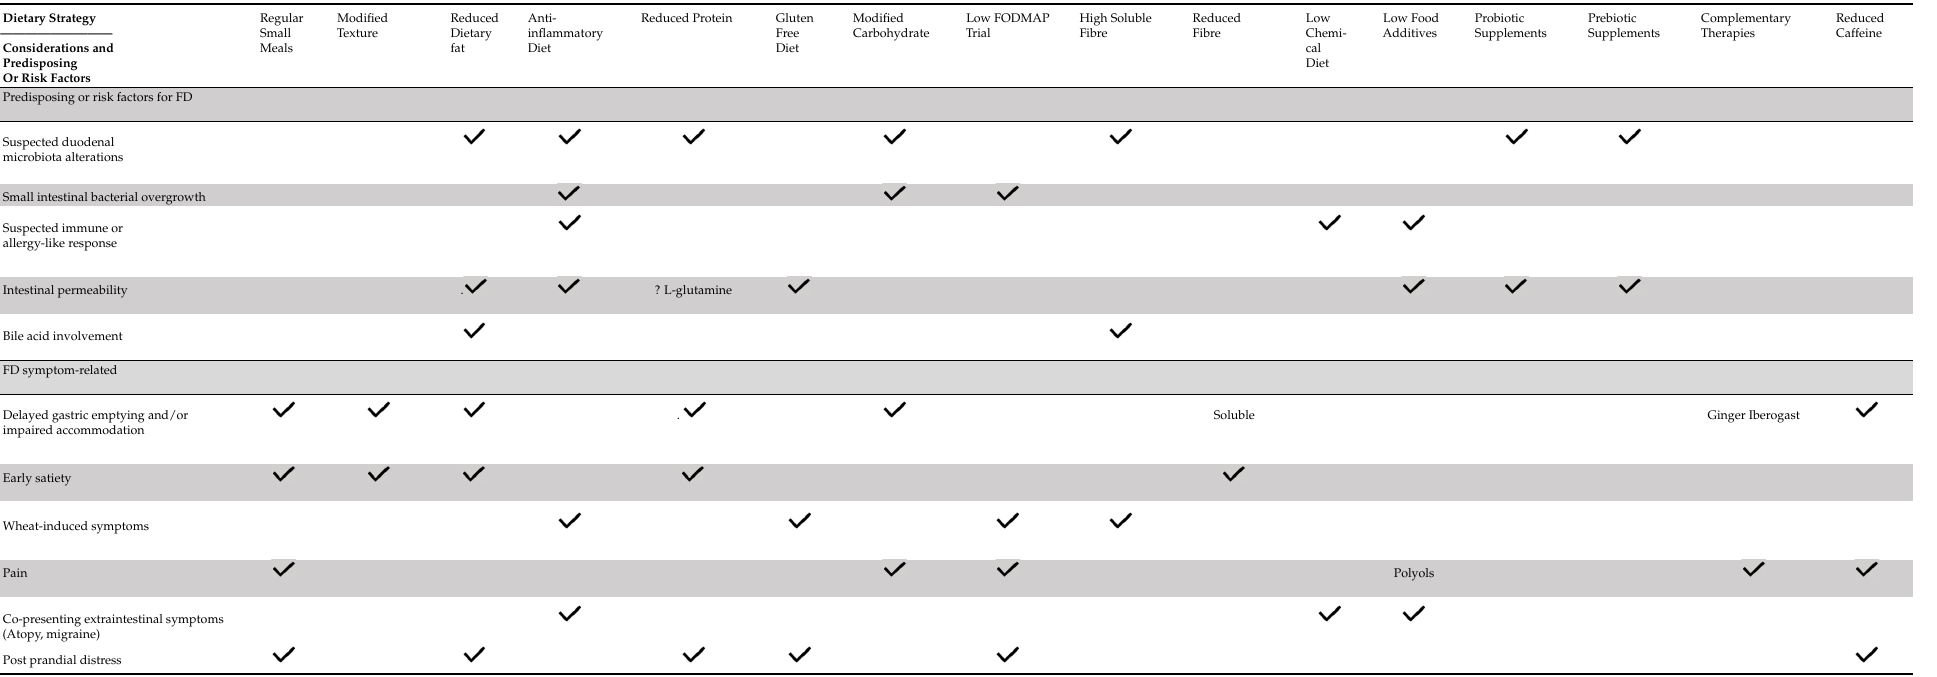
Co-presenting extraintestinal symptoms (Atopy, migraine)